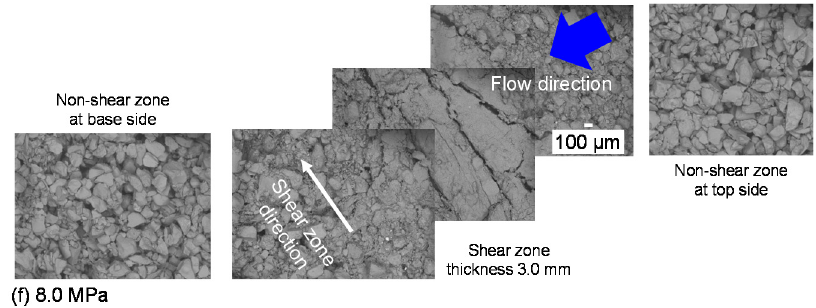
Figure 7. FE-SEM images of shear zones and non-shear zones for silica sand No. 7 at each effective normal stress. Continued for silica sand No. 7 at ( a ) 0.5 MPa; ( b ) 1.0 MPa;